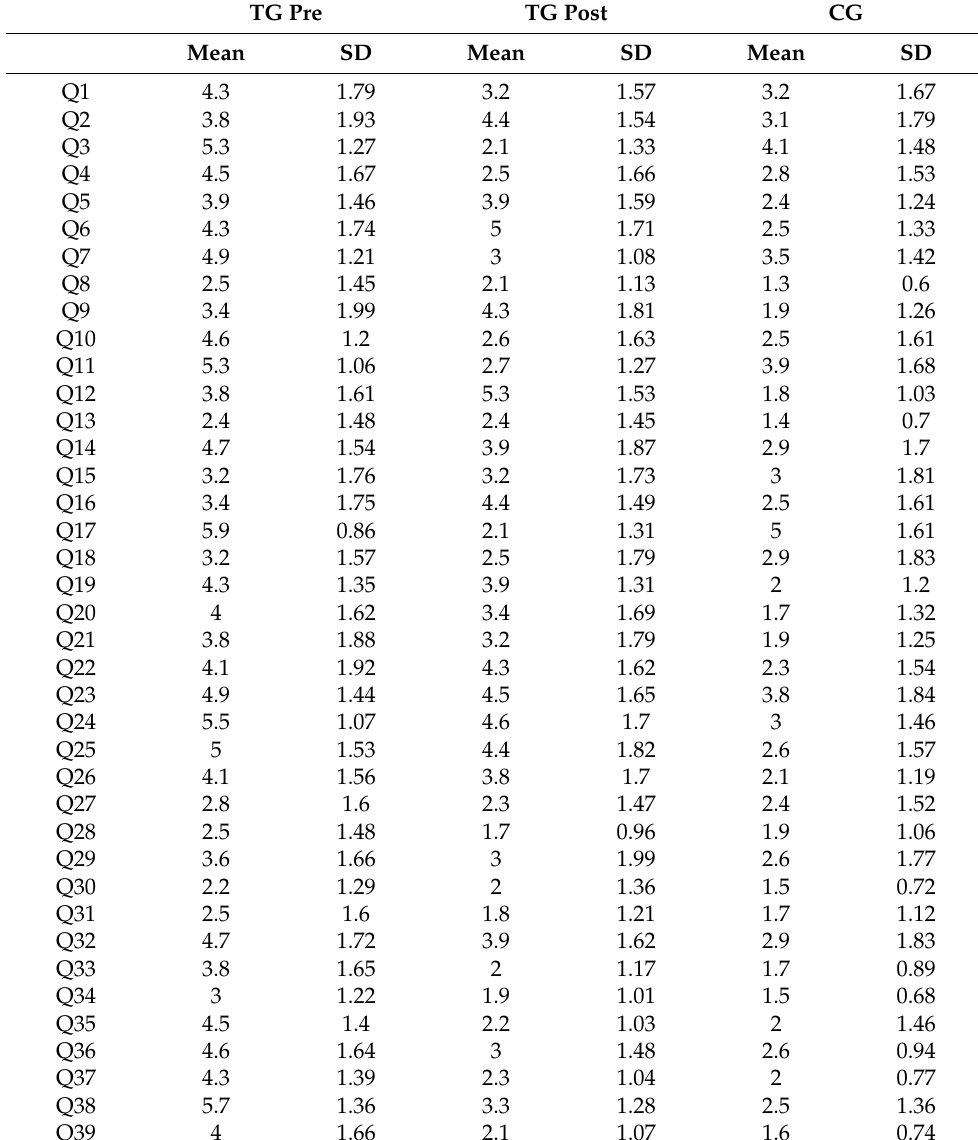
Table 2. Driving behavior survey comparisons—means and standard deviations